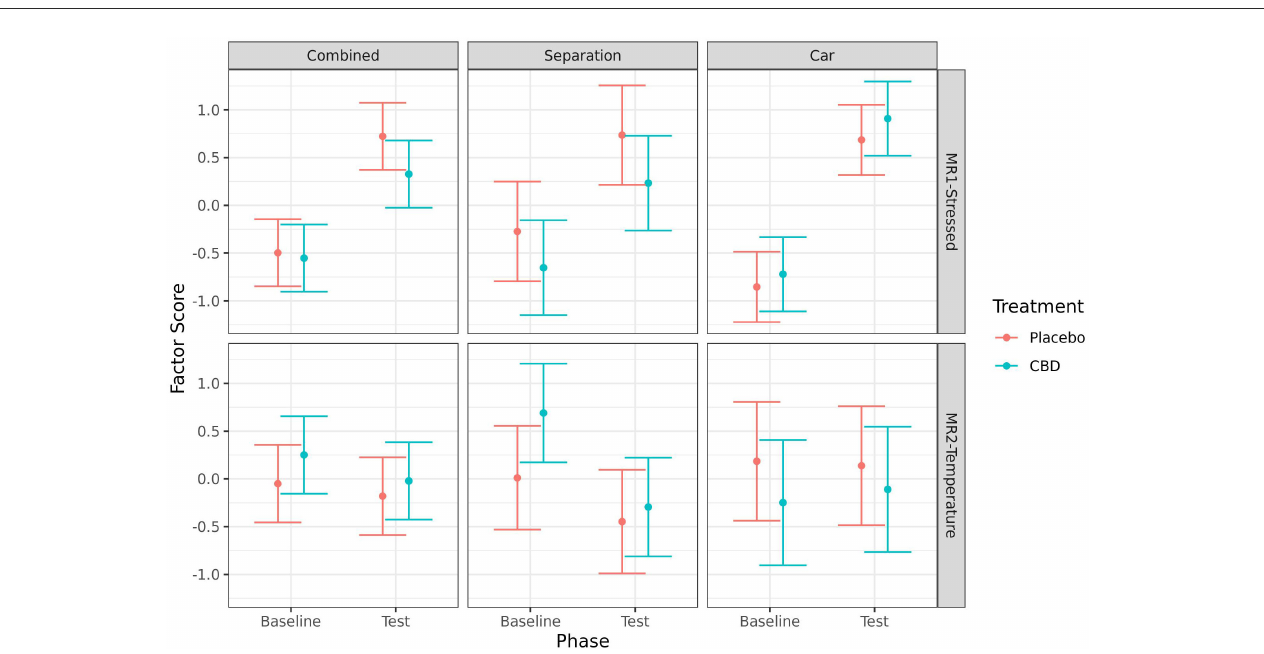
FIGURE11 Predicted mean (95% CI) factor scores indicating levels of “stressed” (MR1), or “temperature” (MR2) for dogs given CBD or placebo at each phase of testing (baseline and test) based on models analyzing both stress tests combined, separation test or car test. Asterisks indicate significant differences between treatment groups within each phase. No significant differences (p < 0.05) were identified between treatment groups within each